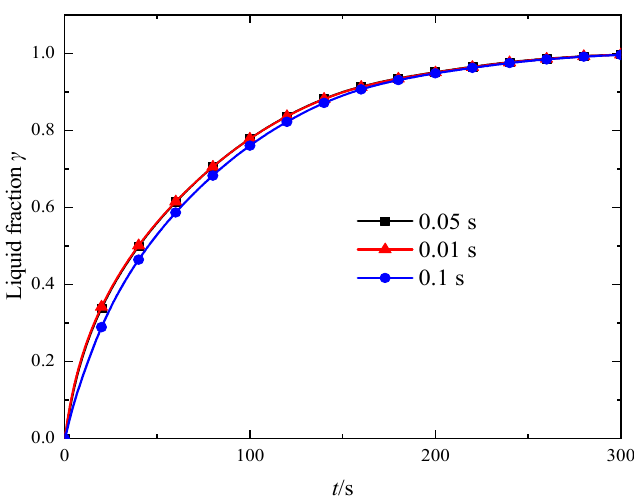
Figure 2. Grid independence validation.